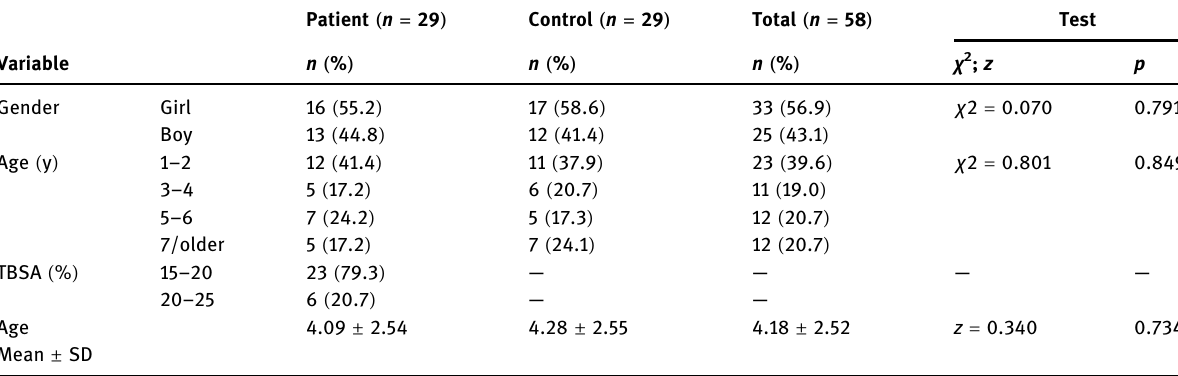
Table 1: Comparison of the groups by gender, age, and TBSA